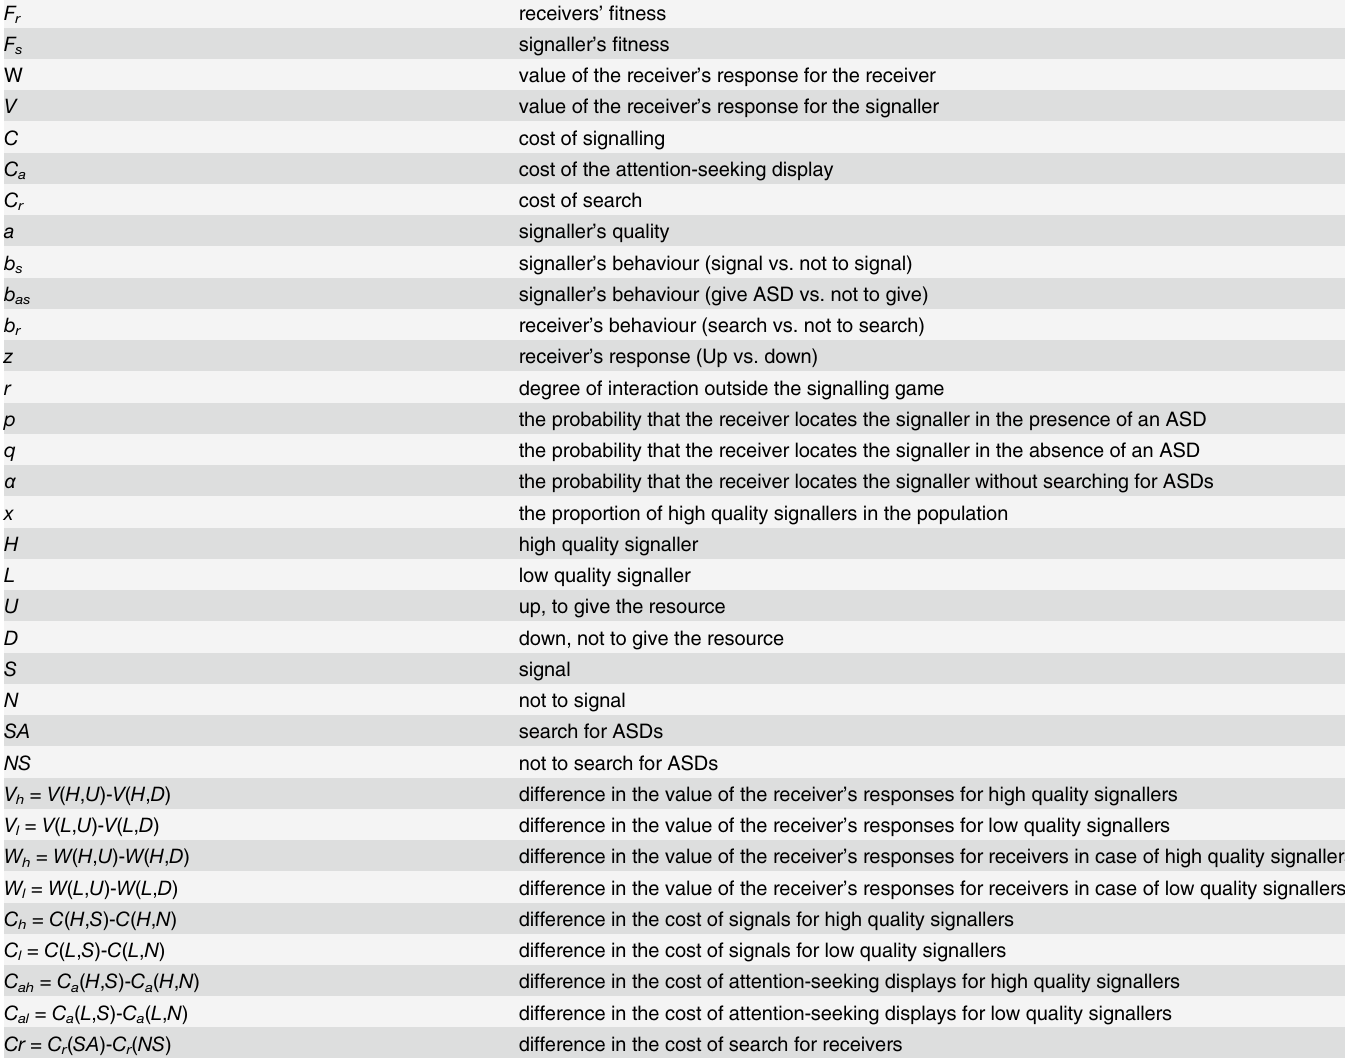
Table 1. Variables, parameters and notations of the